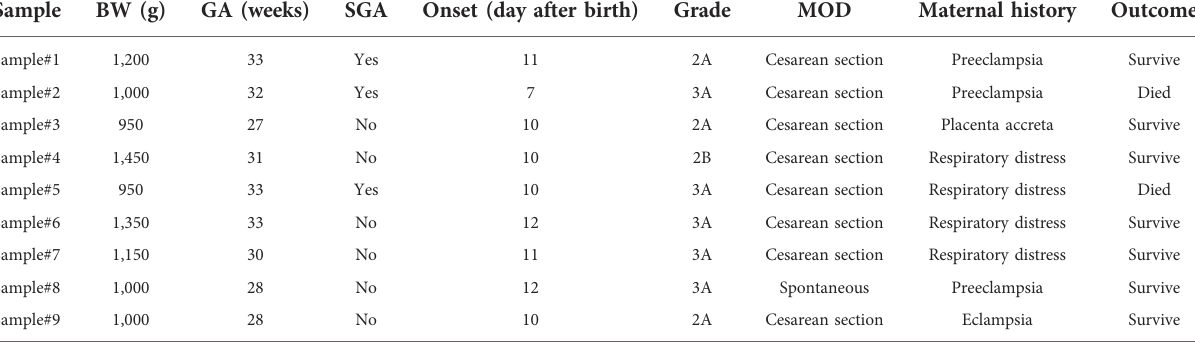
TABLE 2 Characteristics of infants with NEC.